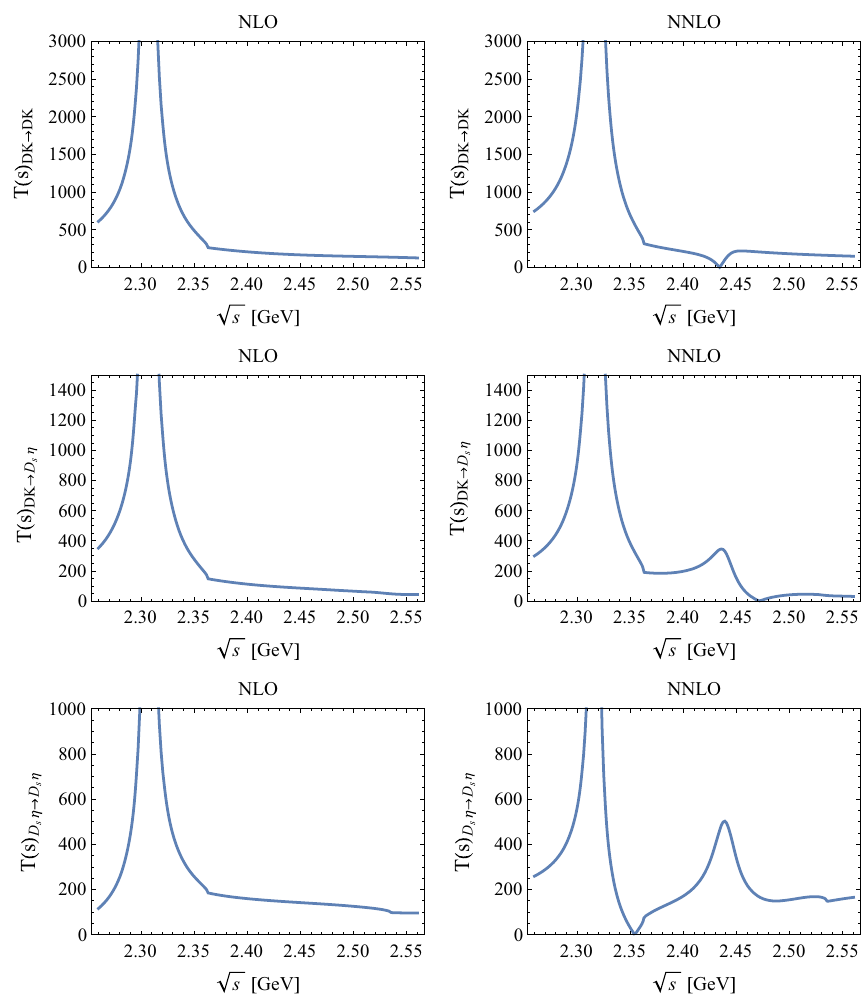
Fig. 4 Absolute values of amplitudes for ( S , I ) = ( 1 , 0 ) in NLO and NNLO calculations,